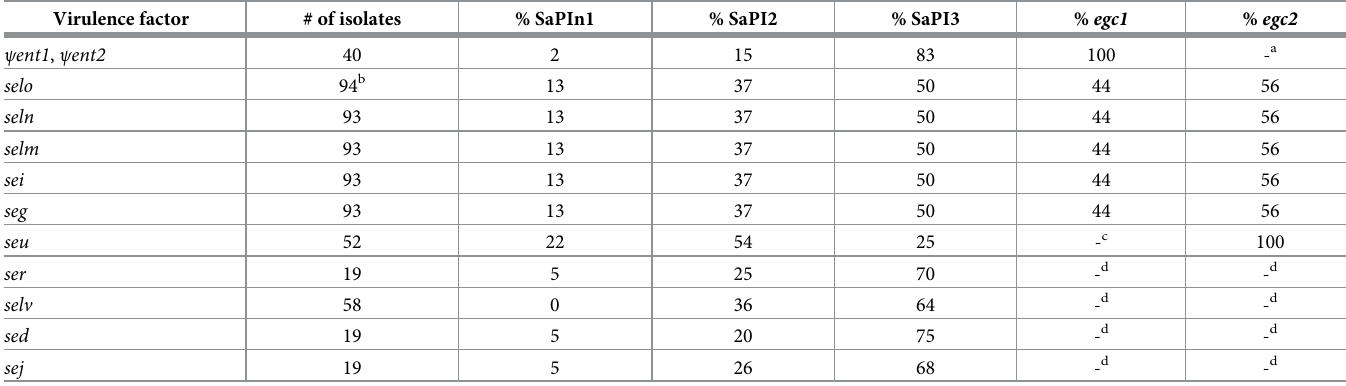
Table 3. Genetic location of enterotoxins found to be significantly enriched among 163 ocular S . aureus